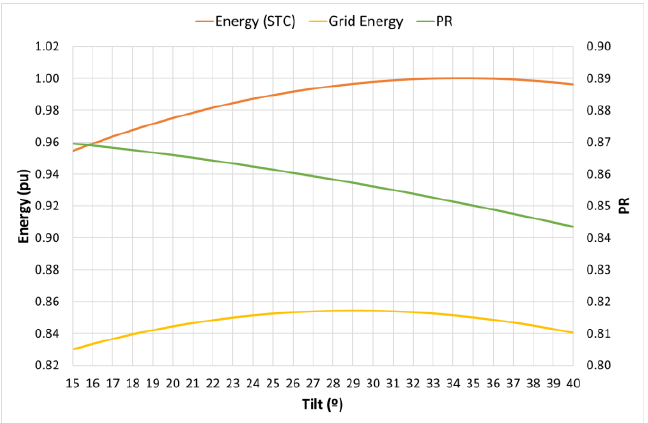
Figure 2. Example of Energy (Standard Test Conditions, or STC), grid-injected energy and Performance Ratio (PR) as a function of tilt.